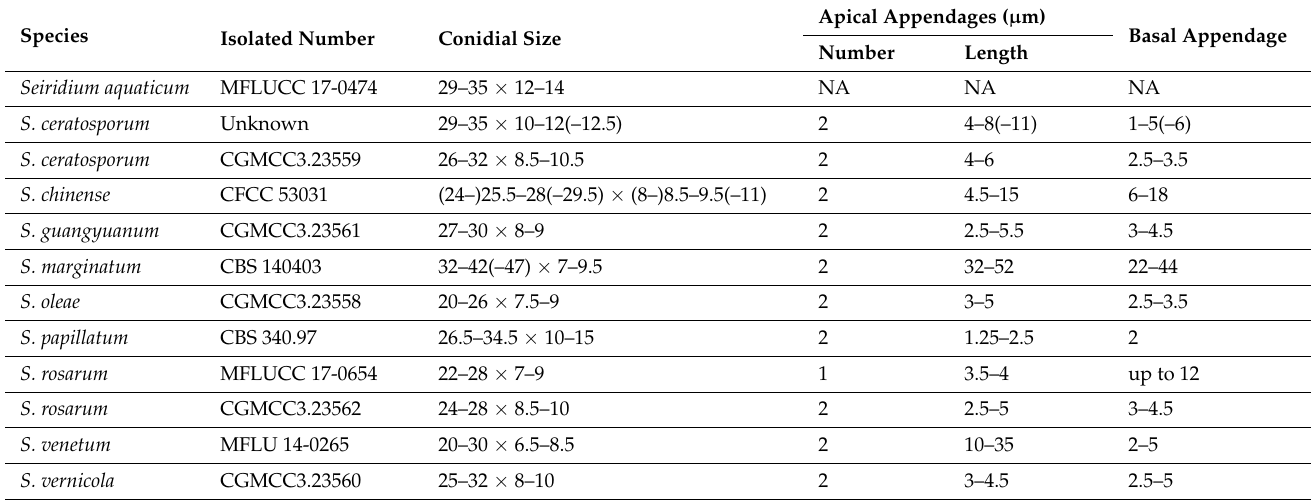
Table 4. Comparison of conidial dimension of Seiridium species related to this